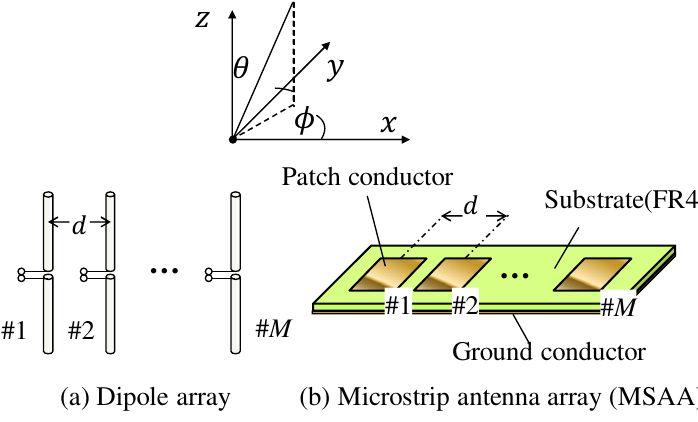
Figure 7. Antenna